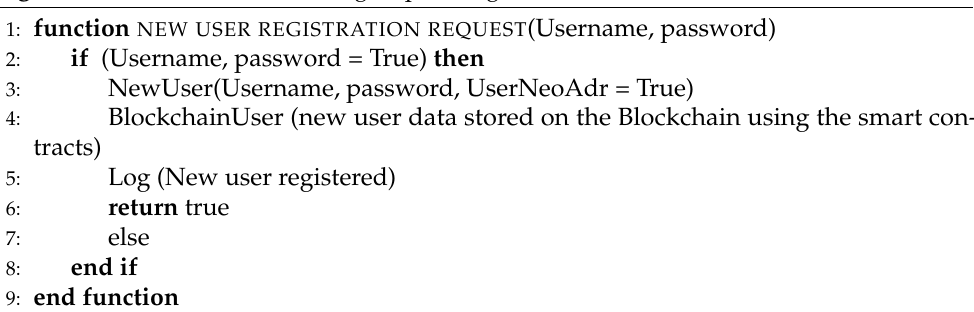
Algorithm 1 Pseudocode showing steps to register